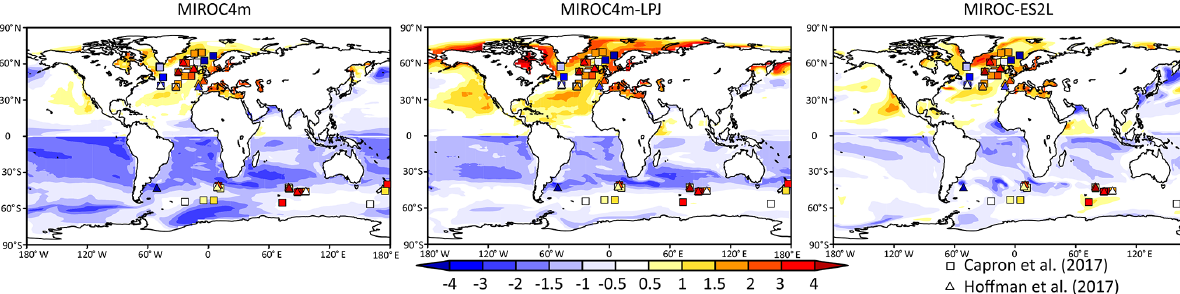
Figure 8. The summer (JJA in NH, DJF in SH) sea surface temperature change (K) in 127k from PI is compared with reconstructions by Capron et al. (2017) and Hoffman et al. (2017). The calendar for 127k is adjusted using a method based on Bartlein and Shafer